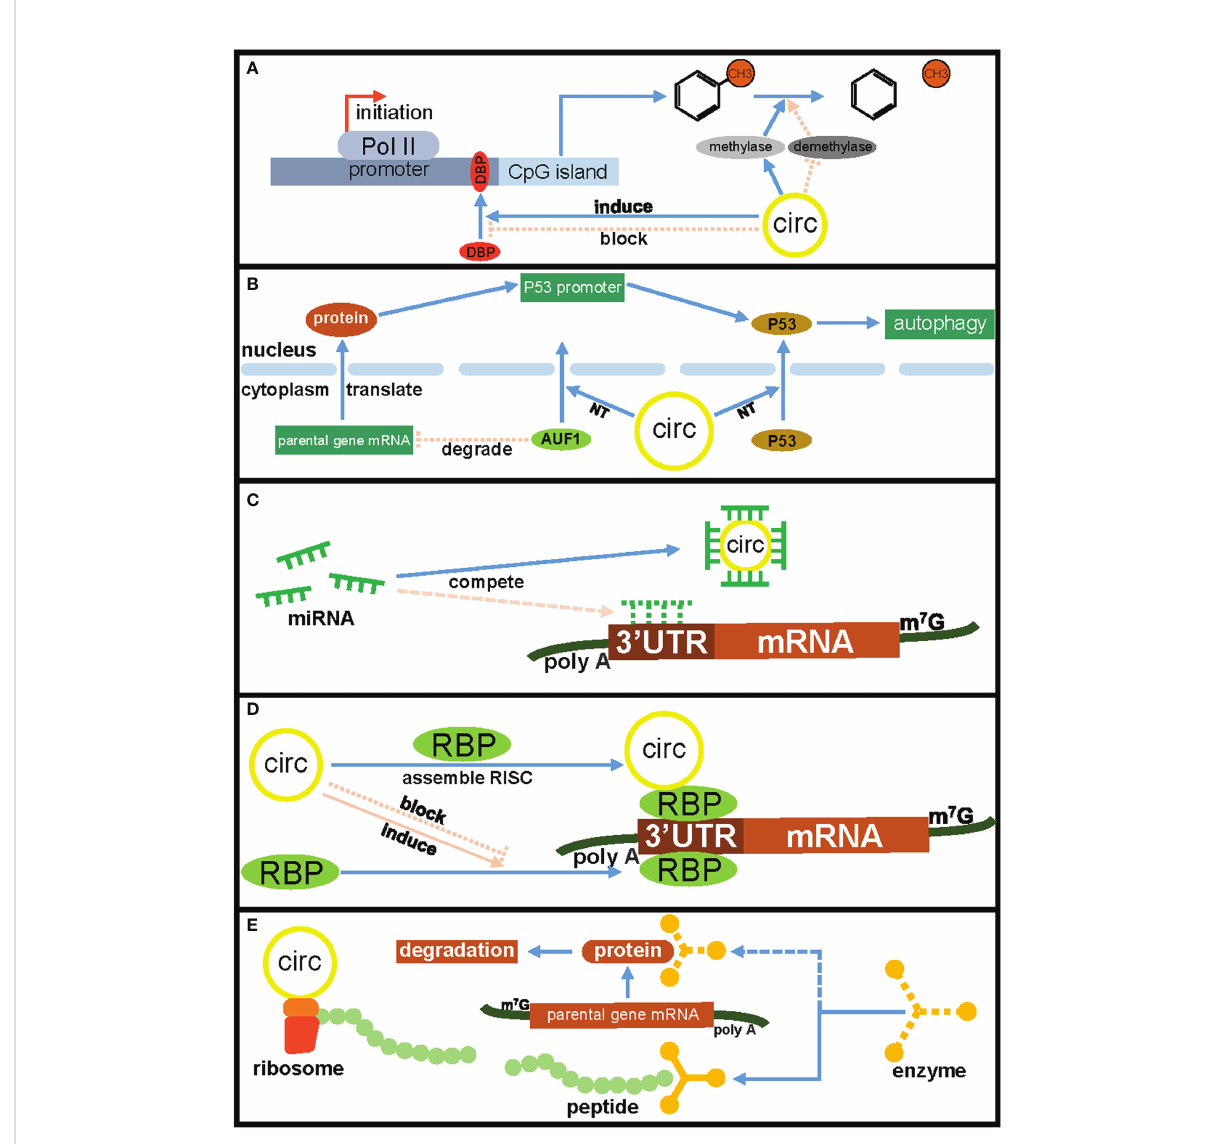
FIGURE 1 The mechanisms of circRNAs regulated parental gene expression. (A) CircRNAs affect parental gene transcription by competing for DNA binding proteins and in fl uencing DNA methylation. (B) CircRNAs regulate parental gene expression by inducing nuclear translocation of RNA binding protein and tumor suppressor protein P53. (C) CircRNAs regulate parental gene expression through the ceRNA mechanism. (D) CircRNAs regulate parental gene expression by competing for RNA-binding proteins. (E) CircRNAs regulate parental genes encoded protein degradation by encoding peptides. CIRC, circRNAs; DBP, DNA binding protein; NT, nuclear translocation; RBP, RNA binding